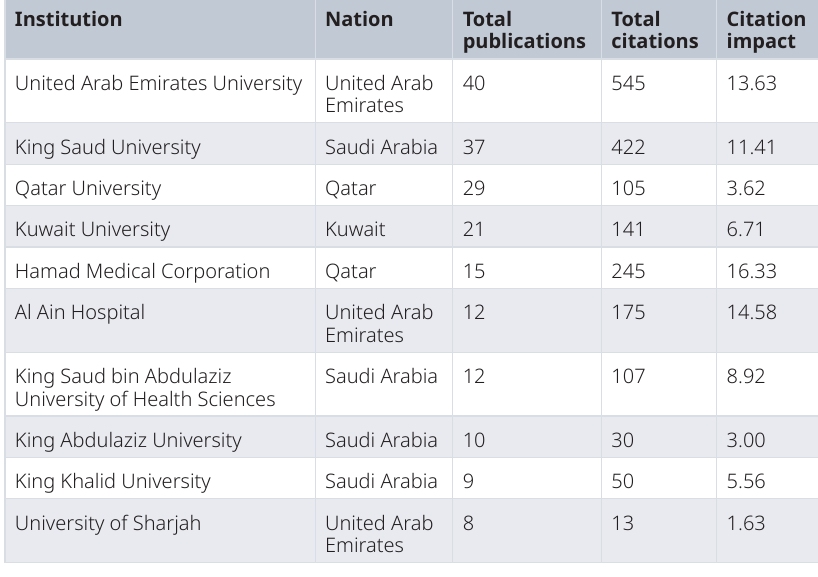
Table 3. Most productive institutions for road traffic injuries research in the Gulf Cooperation Council region